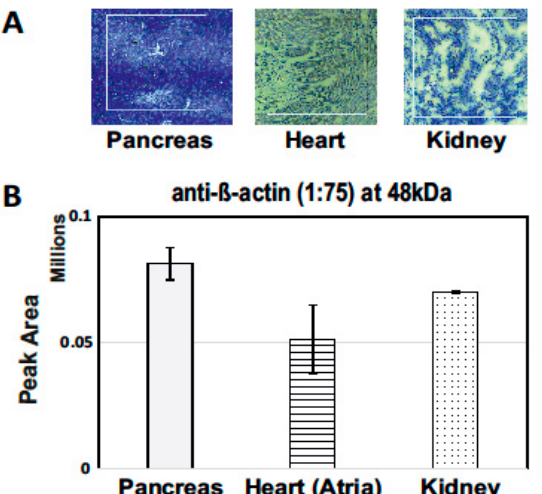
Figure 4. Signal response of β -actin on 0.25 mm 2 dissected LCM samples from the pancreas, heart,